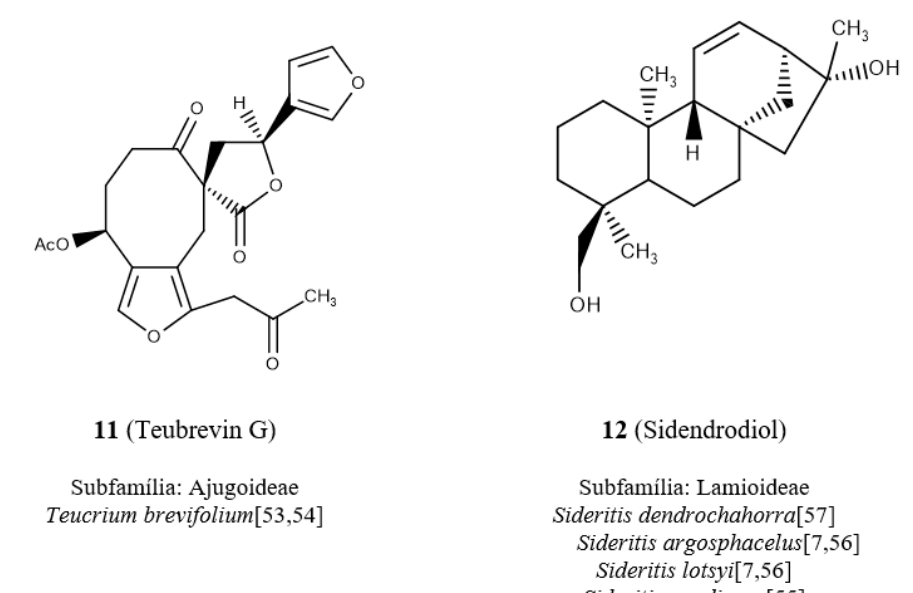
Figure 5. Chemical structures of diterpenes located in SOM and their respective botanical occurrences.